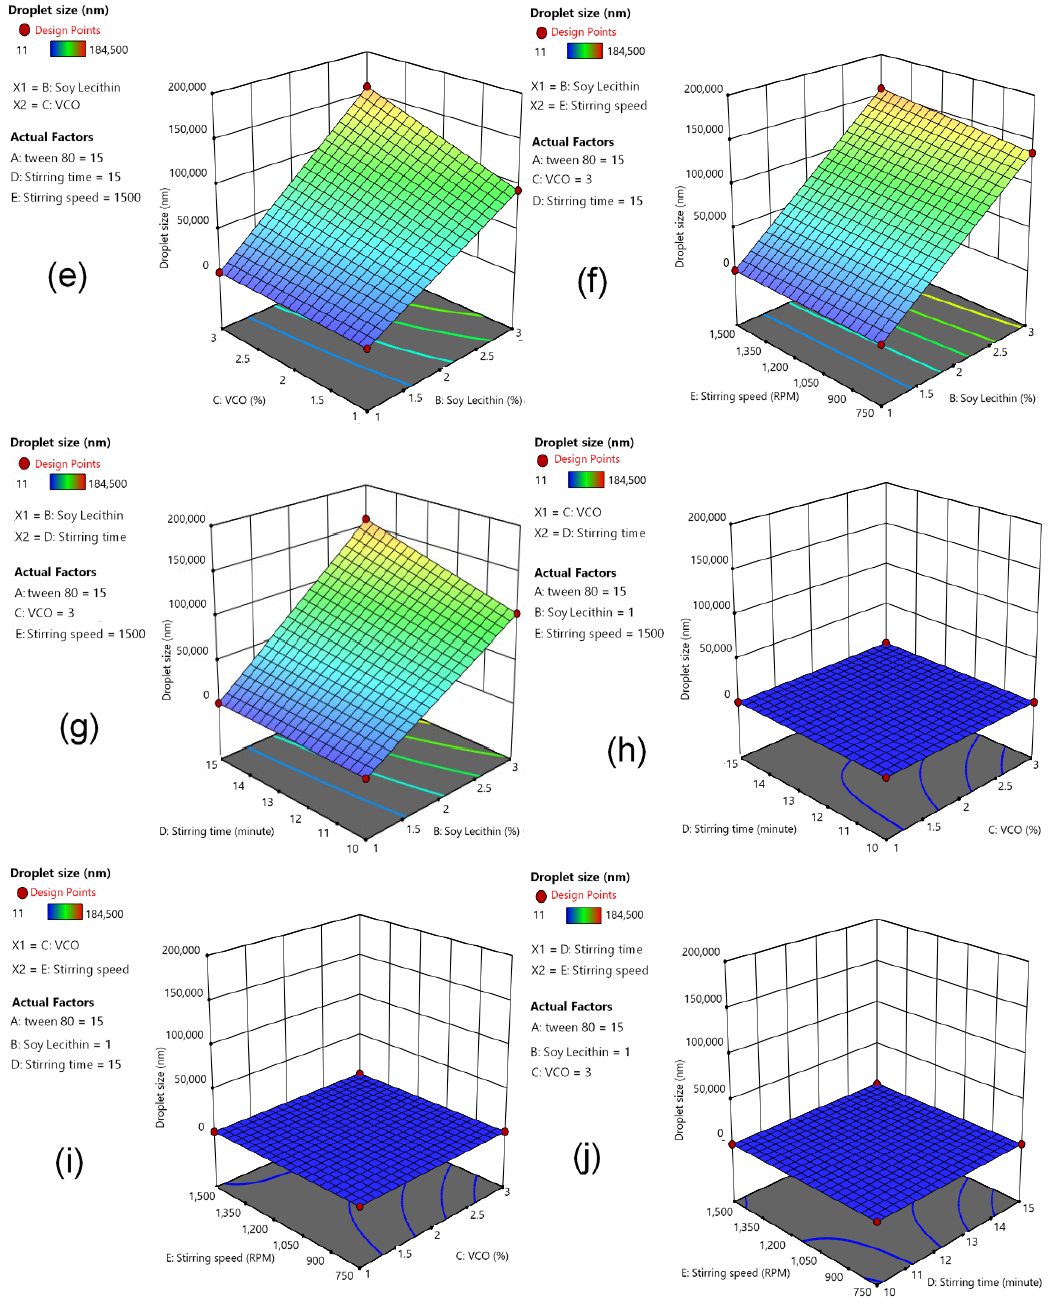
Figure 1. The 3D response surface plots of Tween 80 vs. soy lecithin ( a ), Tween 80 vs. VCO ( b ), Tween 80 vs. stirring time ( c ), Tween 80 vs. stirring speed ( d ), soy lecithin vs. VCO ( e ), soy lecithin vs. stirring speed ( f ), soy lecithin vs. stirring time ( g ), VCO vs. stirring time ( h ), VCO vs. stirring speed ( i ), and stirring speed vs. stirring time ( j ) on the dependent variable of droplet size.